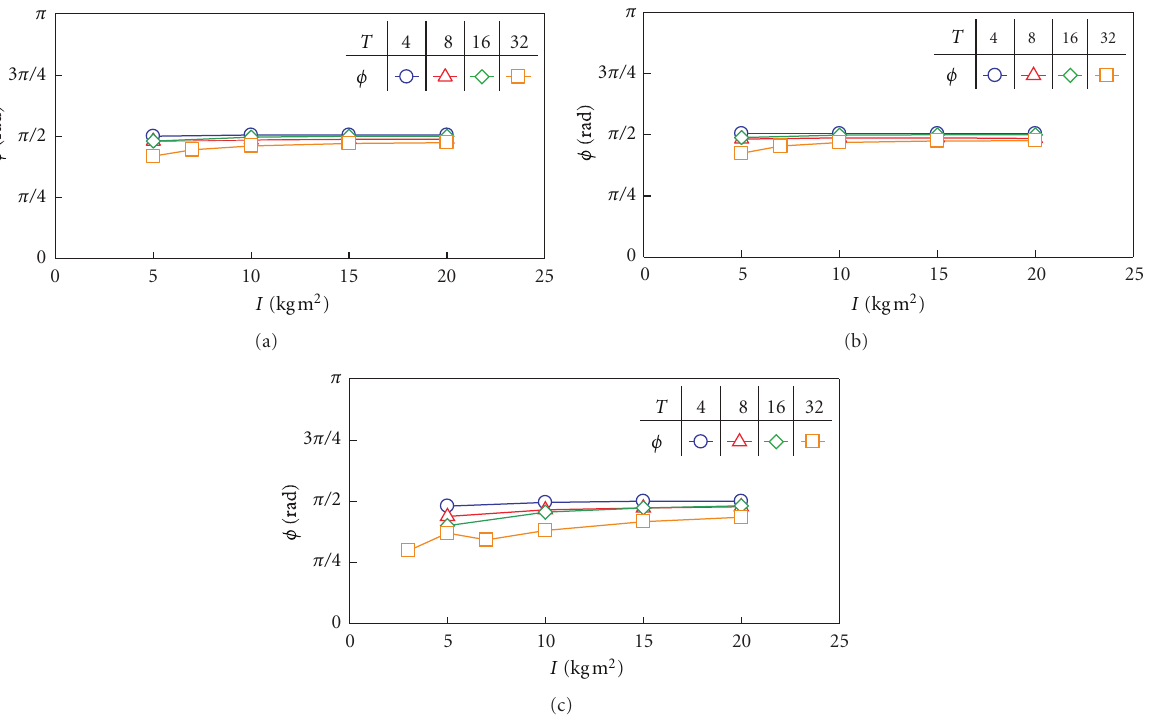
Figure 15: Phase delay, φ , for mean wind speed (a) V 0 = 7, (b) V 0 = 10, and (c) V 0 = 13